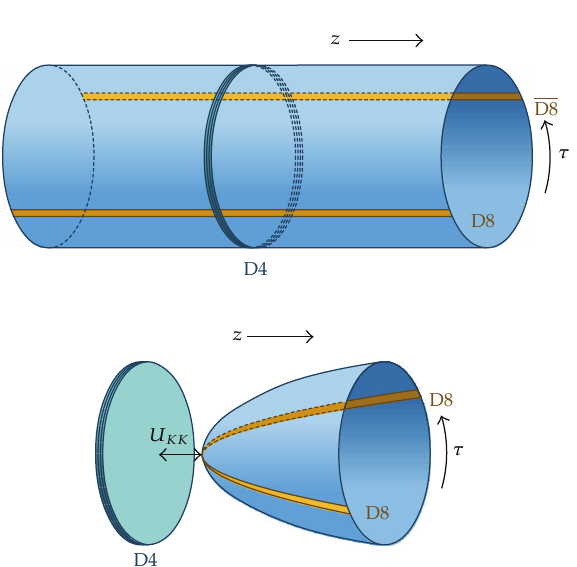
Figure 6: Sketch of the D4 / D8 / D8